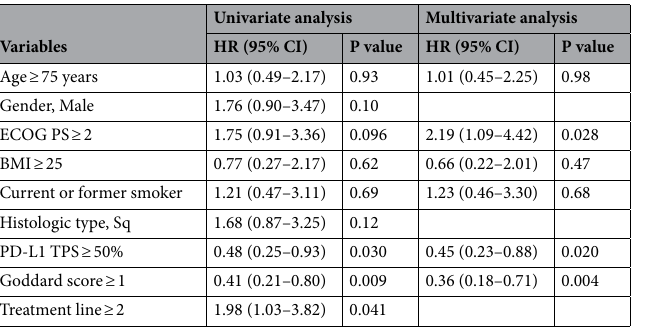
Table 3. Univariate and multivariate analyses of risk factors related to progression-free survival. Sq squamous cell carcinoma, ECOG PS Eastern Cooperative Oncology Group performance status, BMI body mass index, TPS tumor proportion